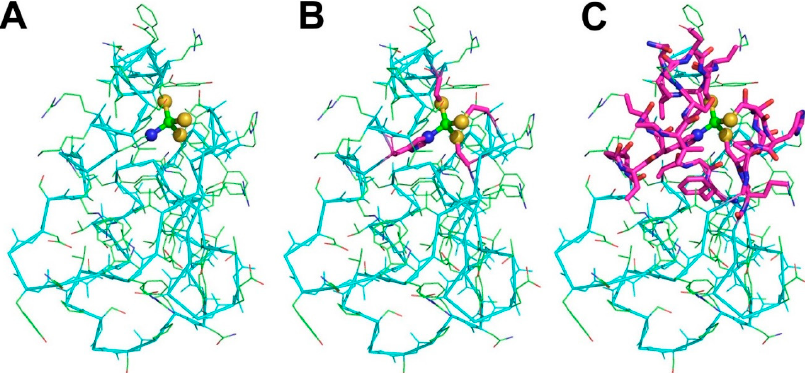
Figure 1. Construction of a Minimal Functional Site (MFS). ( A ) The metal (green sphere) and the donor atoms (blue and gold spheres, for the N ε 2 of a His and the S γ of three Cys); ( B ) the metal-binding site, obtained by including all the atoms of the residues providing the donor atoms (metal ligands, shown as sticks, colored magenta for carbon atoms, blue for nitrogen atoms, red for oxygen atoms, yellow for sulfur atoms); ( C ) the MFS, obtained by additionally including all protein residues with at least one atom within 5 Å from a metal ligand (sticks, same color code as in ( B )). In all panels, the C α trace of the protein backbone is shown as thick cyan sticks, whereas all bonds are shown as thin sticks with the same color code as panel ( B ), except for carbon atoms (green). Note that the two Cys on the right side of the metal ion are in a fragment that is separate from the rest of the MFS. The MBP of this site is CX(2)CX(16)HX(6)C.